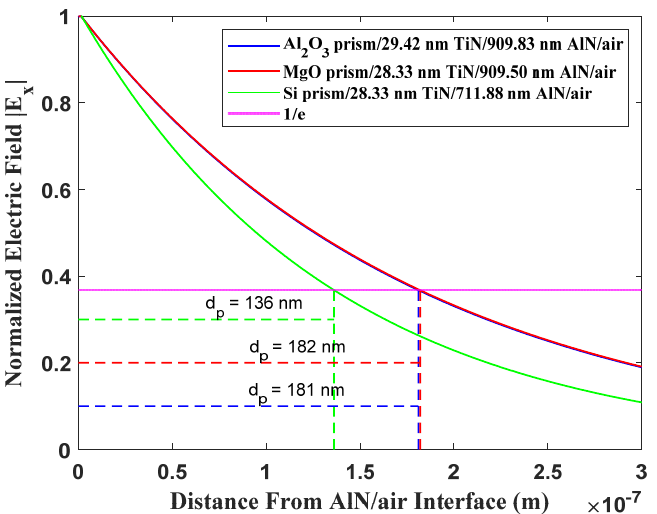
Figure 4. The calculated penetration depth (d p ) for TM–polarized light for the GA–optimized sapphire (Al 2 O 3 ) prism/TiN/AlN/air, magnesium oxide (MgO) prism/TiN/AlN/air, and silicon (Si) prism/TiN/AlN/air sensors was 181 nm, 182 nm, and 136 nm, respectively.